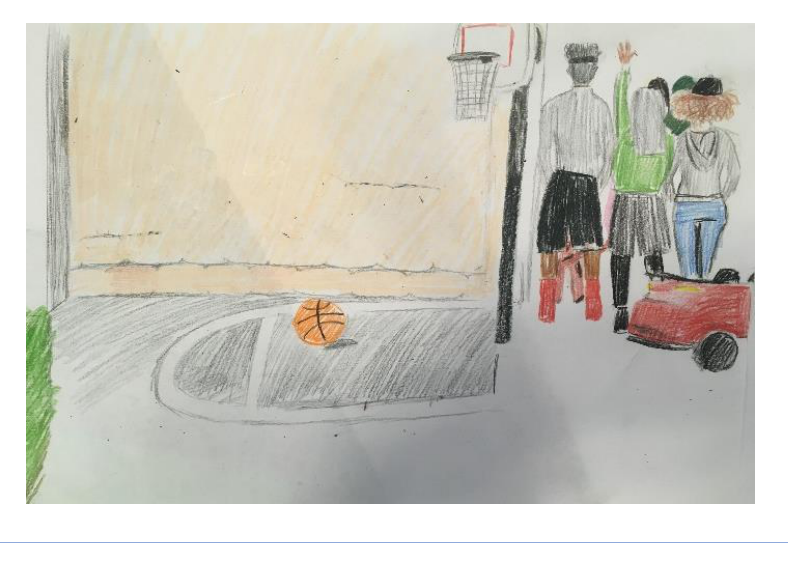
Figure 2. Roodoo’s Perfect